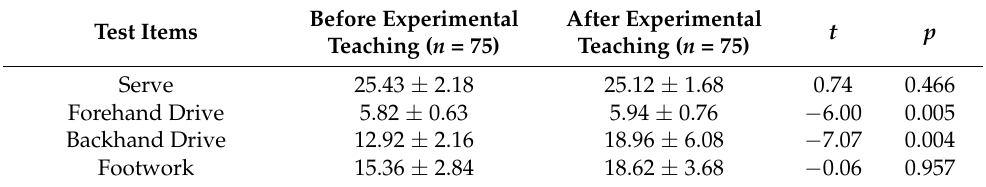
Table 10. Comparison of CG’s Tennis Learning Performance before and after Experimental Teaching.